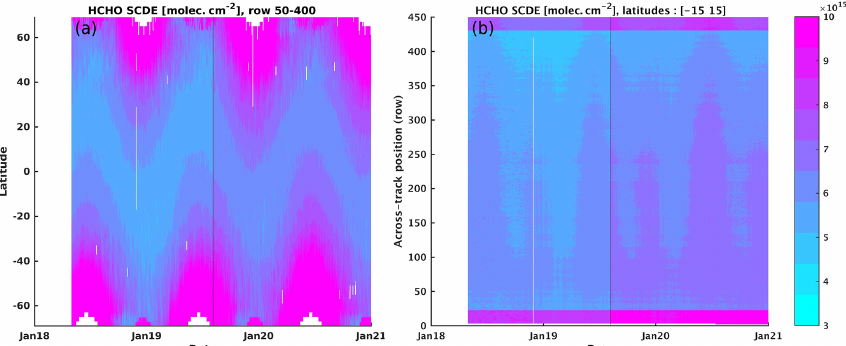
Figure 4. TROPOMI HCHO slant column density errors (SCDEs) as a function of the latitude (a) or the detector row (b) . The step increase on 6 August 2019 reflects the change in the TROPOMI pixel size (indicated with the black line).